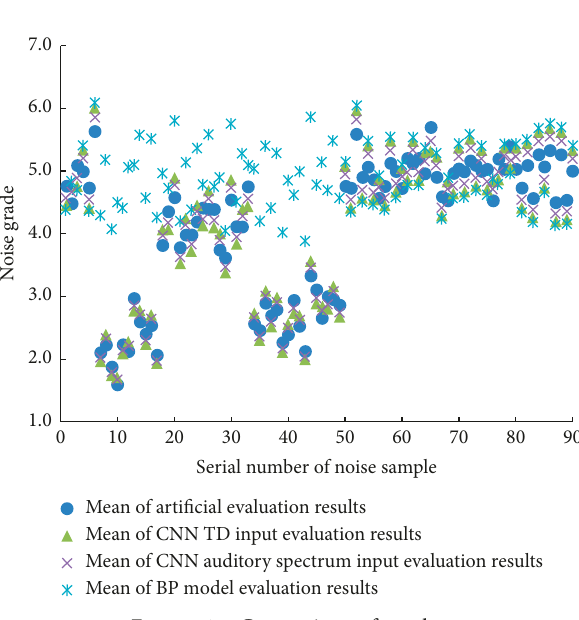
Figure 15: Comparison of results. Table 3: Comparison of test results of two evaluation models.